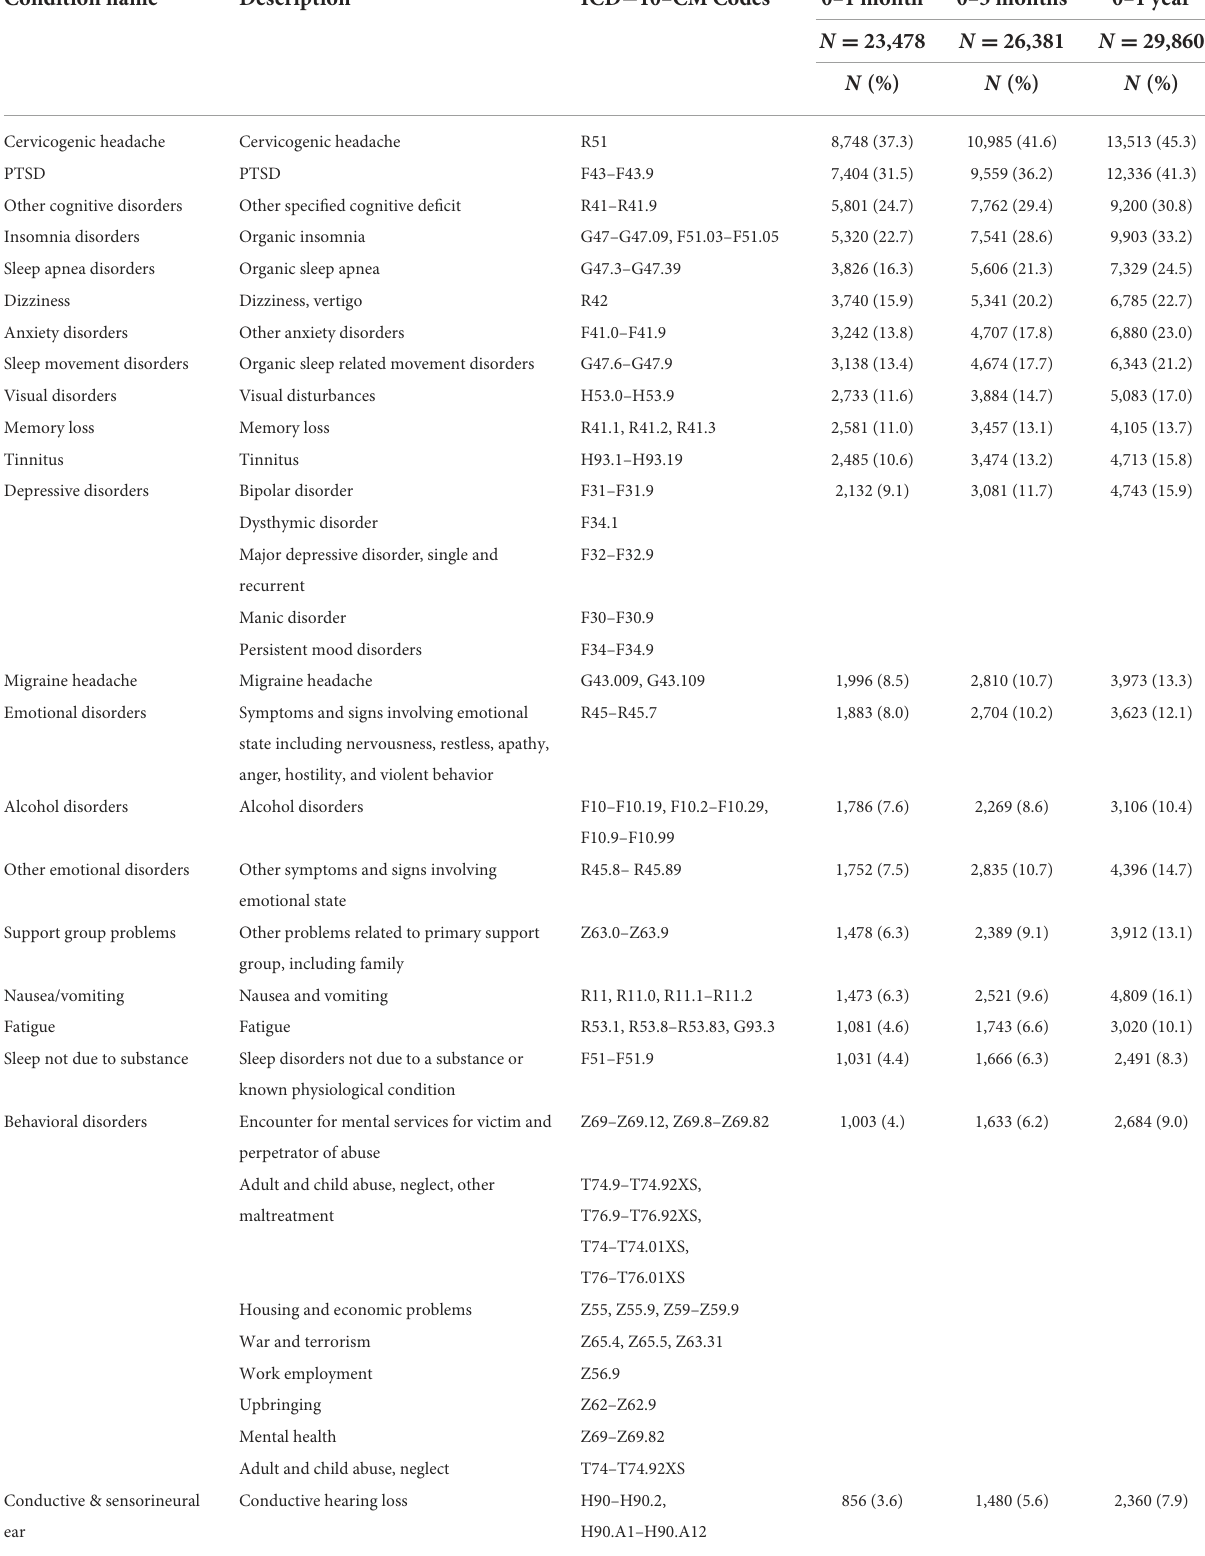
TABLE 2 Prevalence and description of conditions across time for mTBI